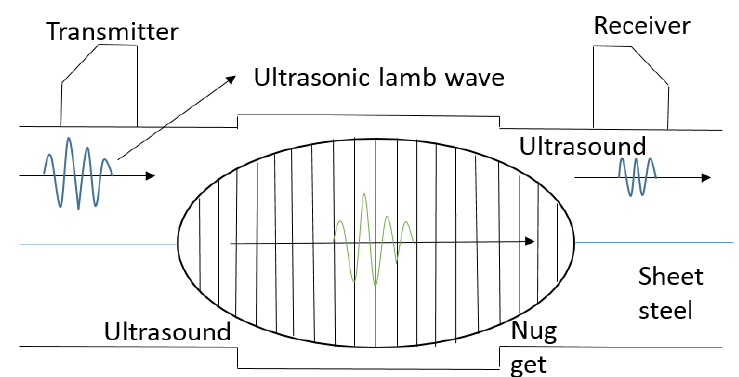
Figure 4. Ultrasonic testing of spot